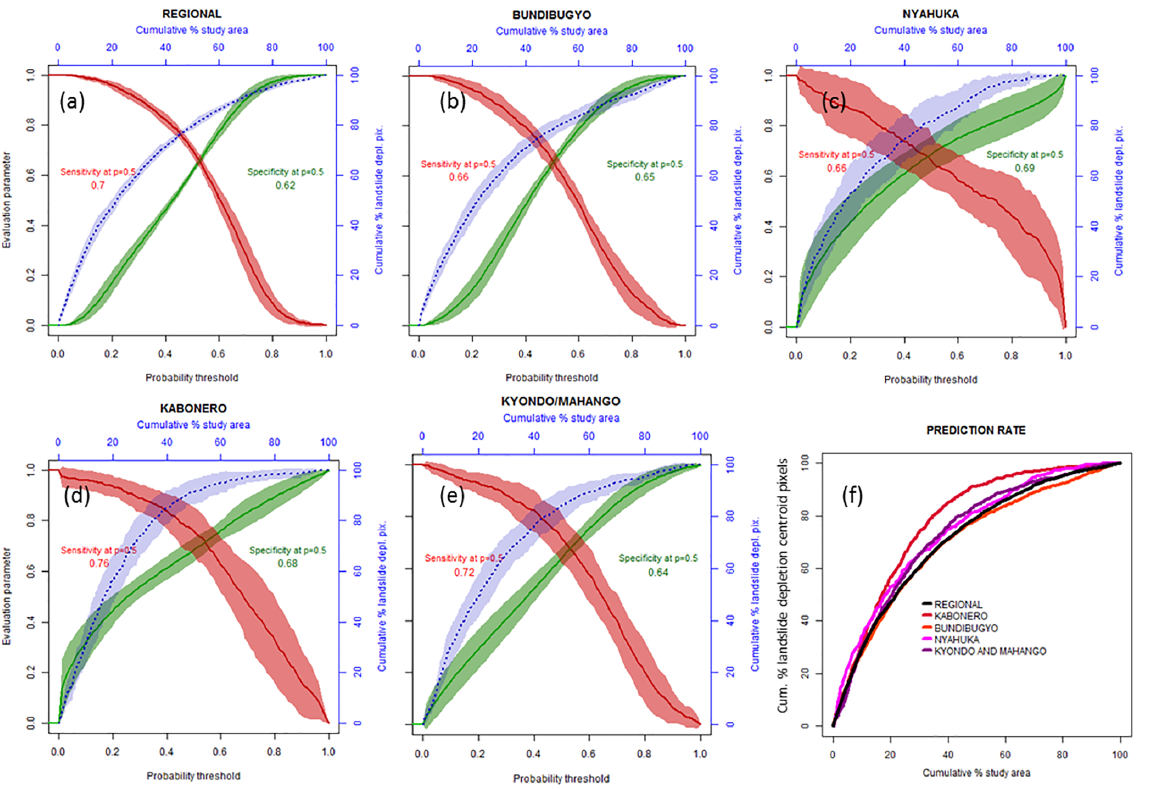
Table 2 also indicates that the best-performing local mod- els with the exception of Bundibugyo have better perfor- mances than the best regional model in terms of AUC ROC